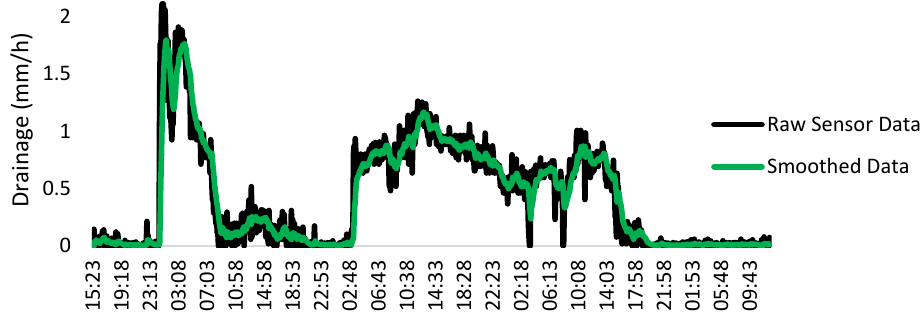
Figure 6. Raw versus smoothed (cleaned) sensor data.